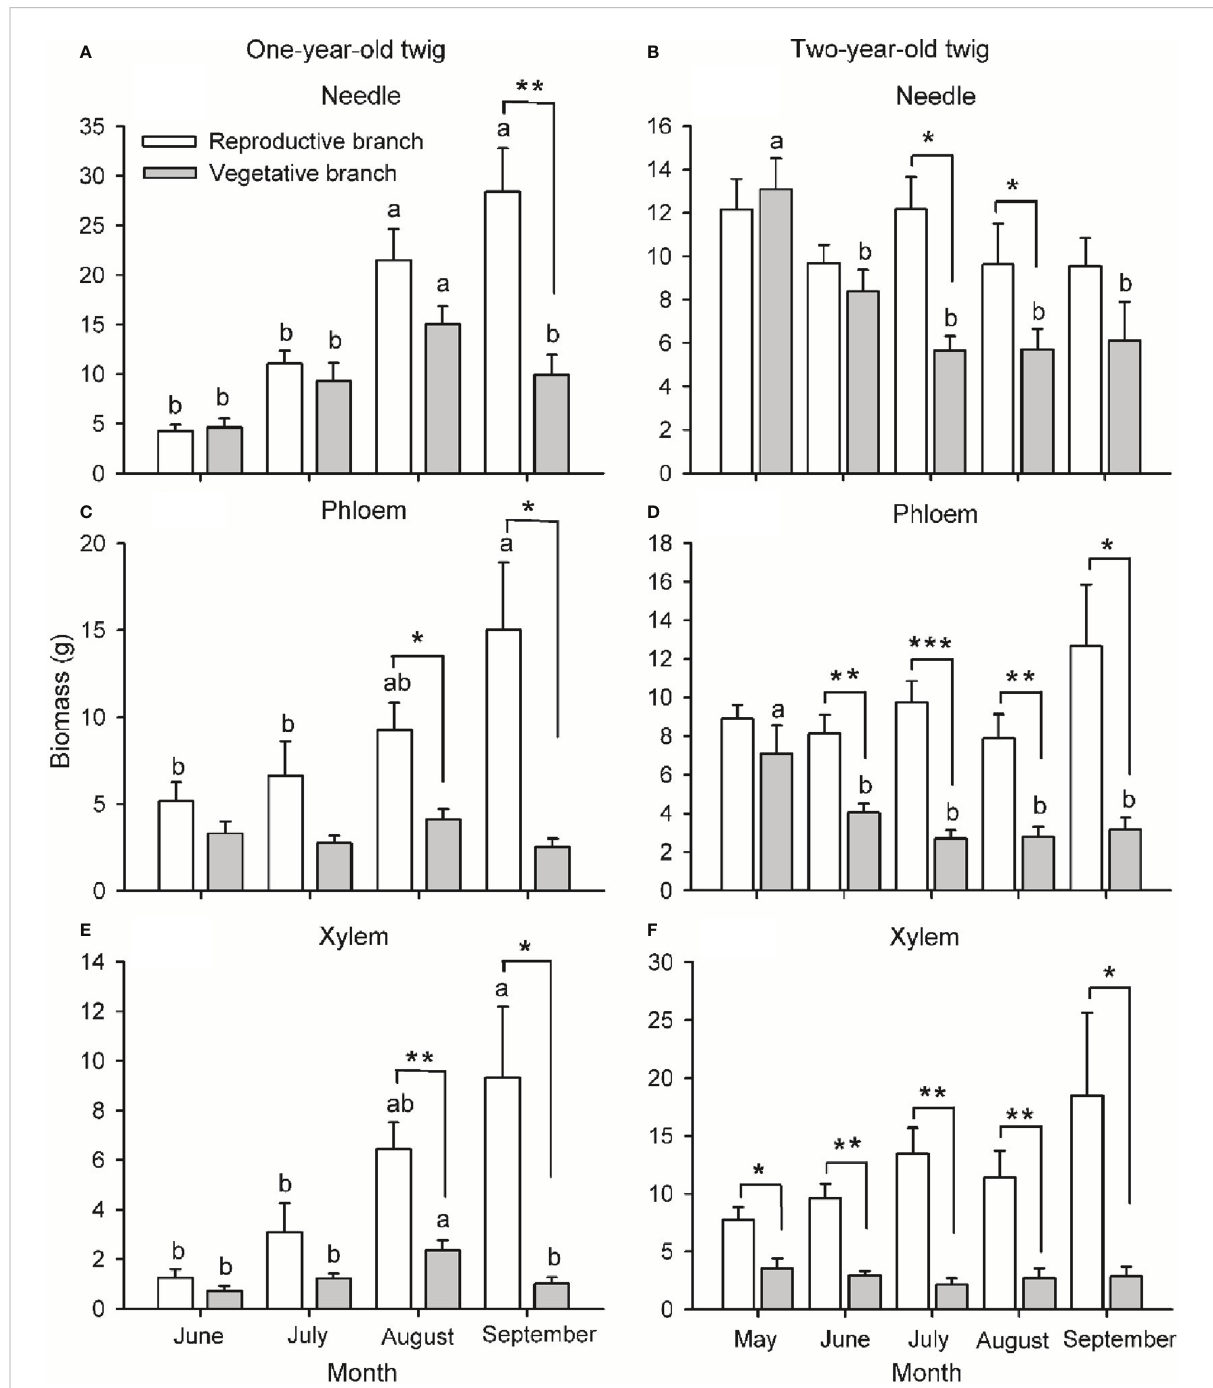
FIGURE 4 Biomass of needle (A, B) , phloem (C, D) and xylem (E, F) of one- (A, C, E) and two-year-old (B, D, F) twigs of Pinus koraiensis at fi ve sampling times (May, June, July, August and September, corresponding to DOYs 128, 172, 204, 237 and 258, respectively). One-year-old twig biomass was nil in May. Bars and arrows represent the mean and corresponding standard error from fi ve trees, respectively. Asterisks indicate signi fi cant differences between branch types for a given harvest time; *, ** and *** indicate signi fi cance levels at P < 0.05, 0.01 and 0.001, respectively. Different lowercase letters indicate signi fi cant differences between harvest times for a given branch